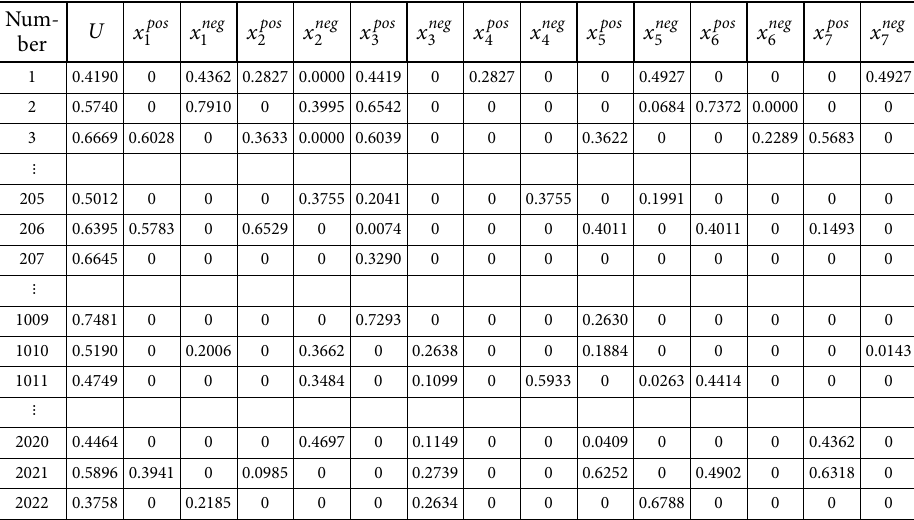
Table 4. Total utility and performance scores for attributes of each online reviews Num-